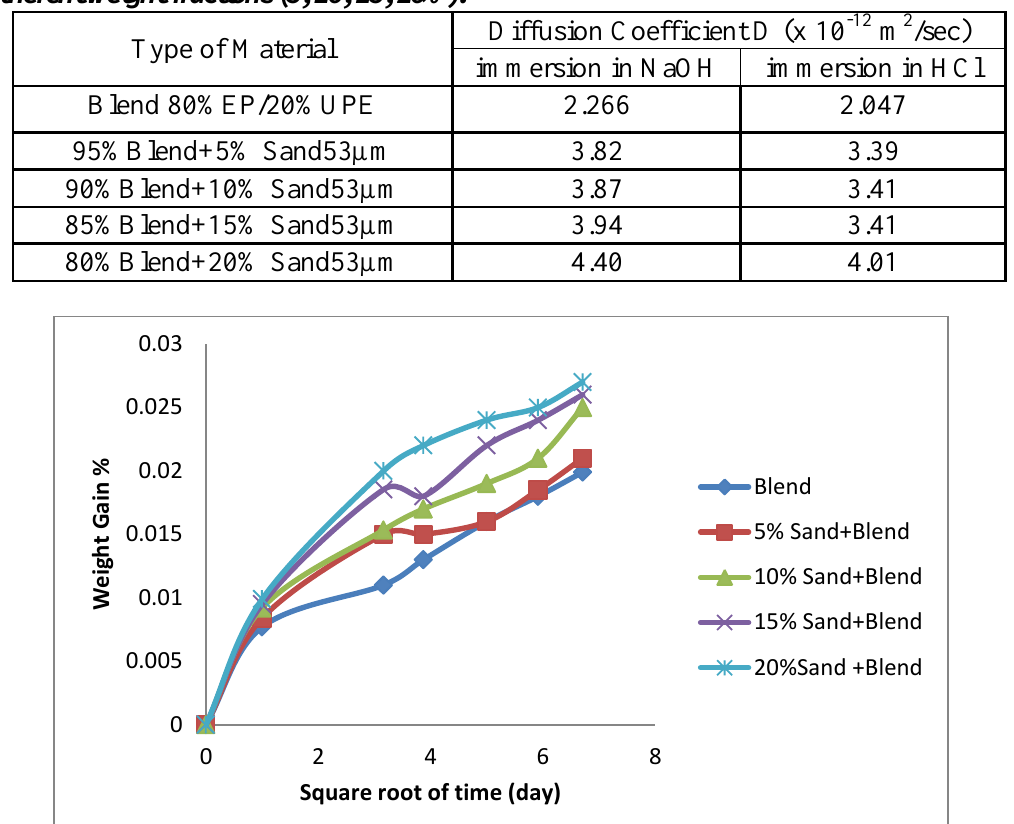
Fig. 4: The relationship between the percentages of absorption of 80%EP/20%UPE reinforced with sand Particles with square root of time after immersion in HCl.